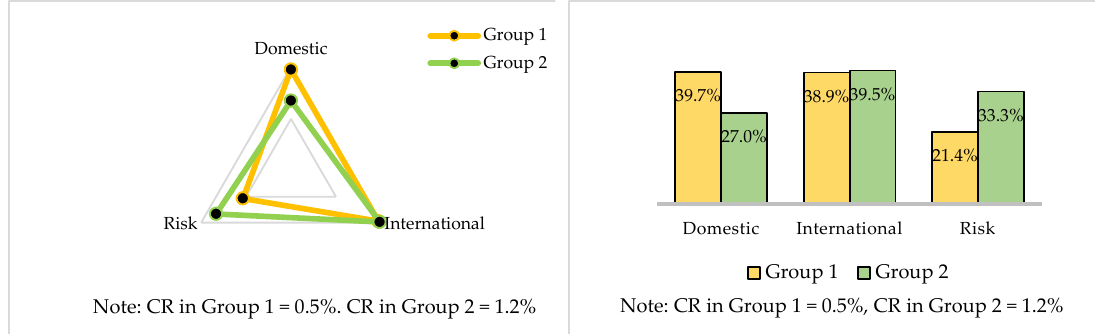
Figure 8 . Local weights for level 2 between group 1 and group 2.